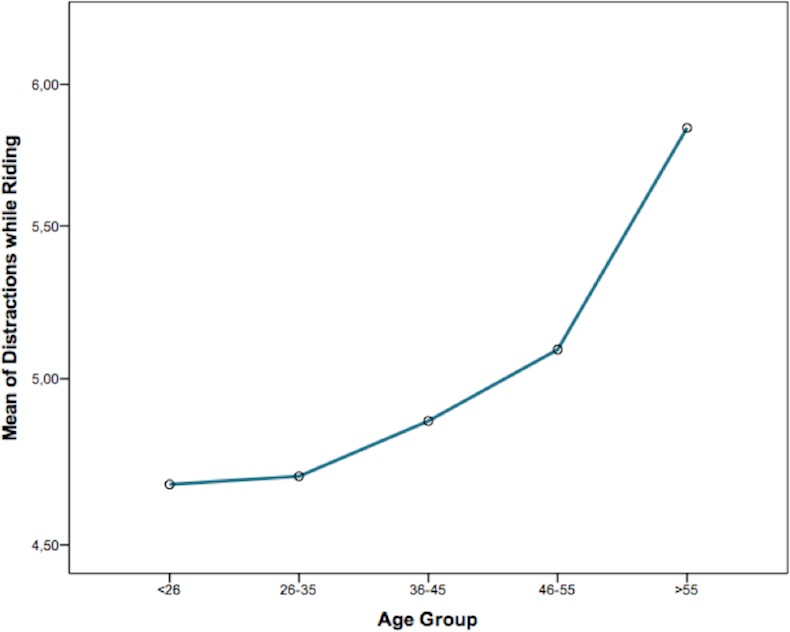
Mean of distractions while riding by age interval.(Comparatively) the average score on cycling distractions of each age group or interval. Overall, this value seems to be increased according to the age of cyclists.